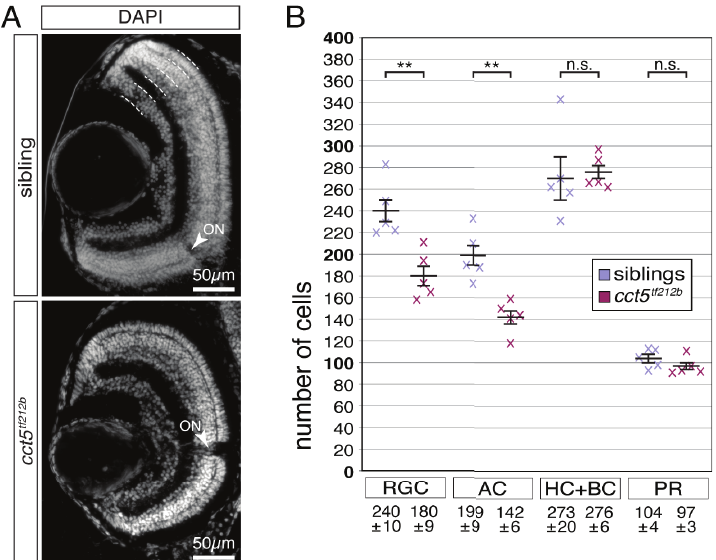
Figure 4. Retinal ganglion and amacrine cells are reduced in number in cct5 𝑡𝑓121𝑏 mutants. (A) At six dpf, the retinal nuclei of siblings and cct5 𝑡𝑓121𝑏 mutants were marked at the level of the optic nerve using the nuclear stain DAPI. Indicated by the dotted lines, the outer nuclear layer contains the photoreceptor cells (PR). The inner nuclear layer harbours the apical horizontal cells (HC) and the bipolar cells (BC) as well as the basally located amacrine cells (AC). The most basal layer contains the retinal ganglion cells (RGC). Arrowheads indicate optic nerves (ON). (B) Quantification of the cellularity of the different retinal layers within siblings and cct5 𝑡𝑓121𝑏 homozygotes at six dpf. The cell number of the RGC and the AC were significantly reduced in cct5 𝑡𝑓121𝑏 homozygotes. Per retinal cross section, siblings had 240 ± 10 RGC and 199 ± 9 AC in contrast to 180 ± 9 RGC and 142 ± 6 AC in cct5 𝑡𝑓121𝑏 homozygotes. The number of HC and BC as well as PR remained unchanged. Siblings had 273 ± 20 HC and BC as well as 104 ± 24 PR and cct5 𝑡𝑓121𝑏 homozygotes had 276 ± 6 HC and BC as well as 97 ± 3 PR. Data are mean ± SEM; ** P < 0.01 by Student’s t -test; n.s., not significant; n,